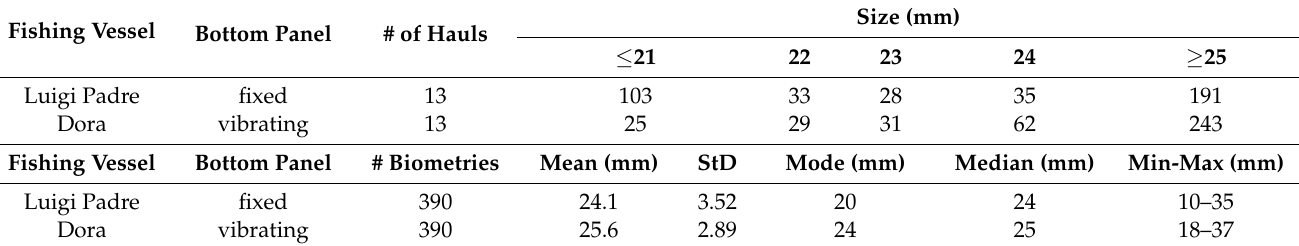
Table 2. Clam biometry with traditional vs. innovative dredge.